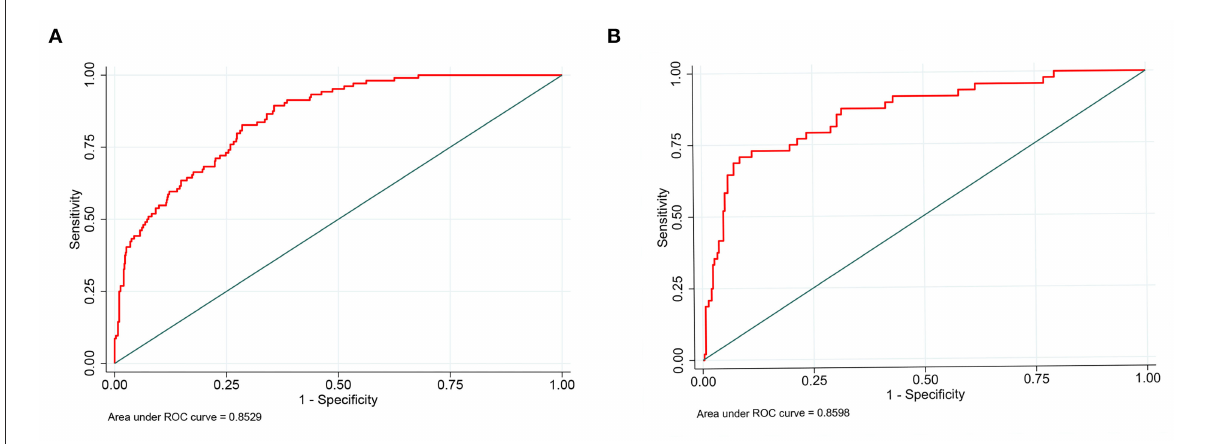
FIGURE3 Receiver operating characteristic curve of the nomogram. The an area under the curve (AUC) of the nomogram for the prediction of acute kidney injury (AKI) in patients with AIS was 0.8529 in the training set (A) and 0.8598 in the validation set (B) .